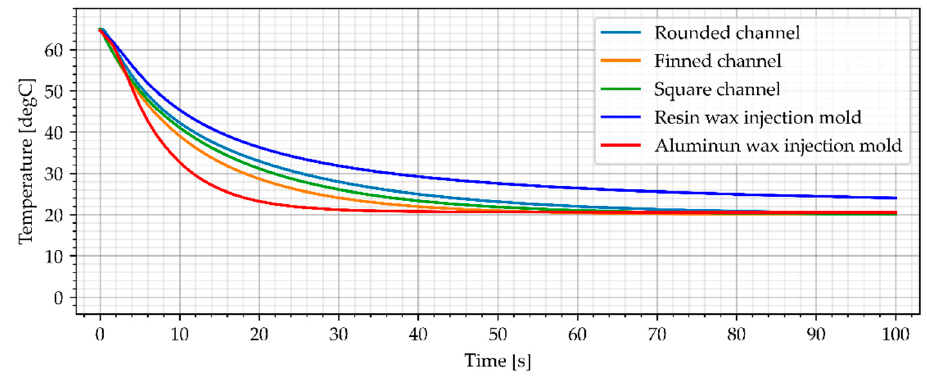
Figure 16. The sample temperature for water cooled wax injection molds (middle point).